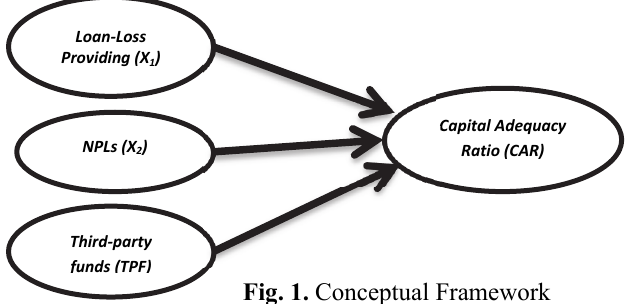
Fig. 1. Conceptual